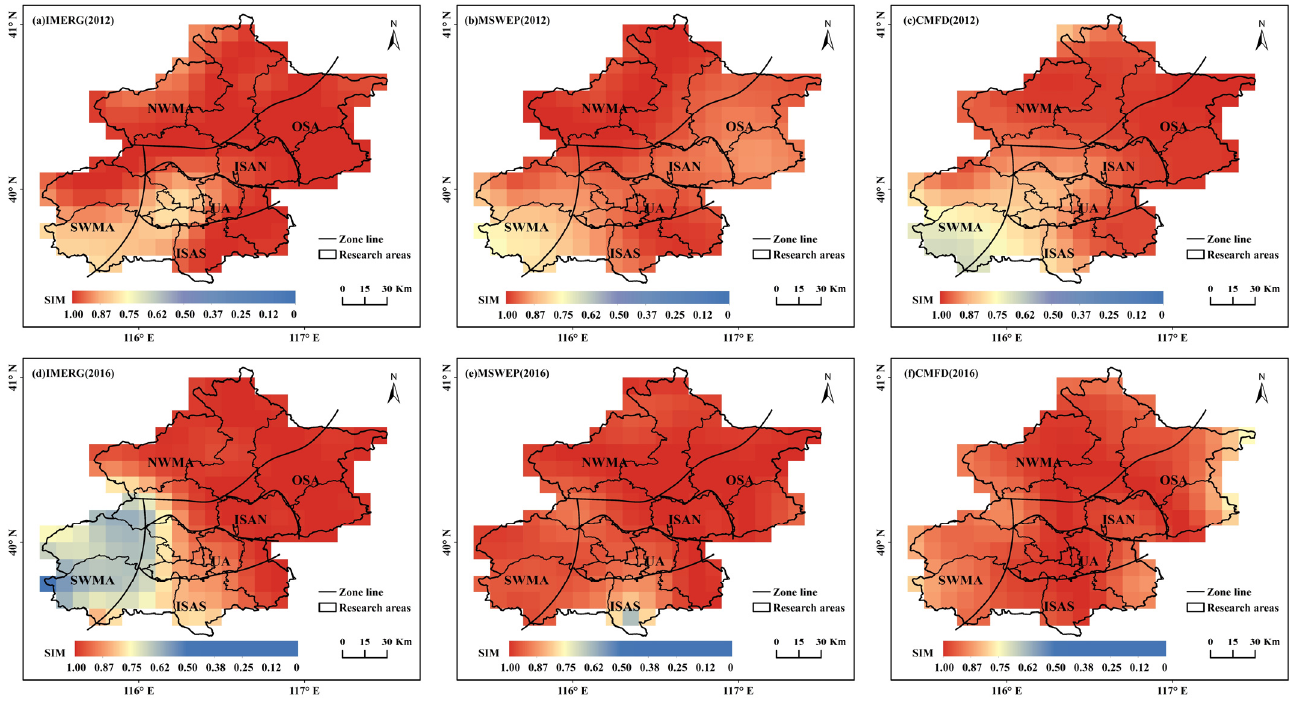
Figure 7. Similarity in mean index (SIM) of the extreme rainstorms that occurred in Beijing on 21 July 2012 and 20 July 2016: ( a ) IMERG (2012), ( b ) MSWEP (2012), ( c ) CMFD (2012), ( d ) IMERG (2016), ( e ) MSWEP (2016), and ( f ) CMFD (2016).